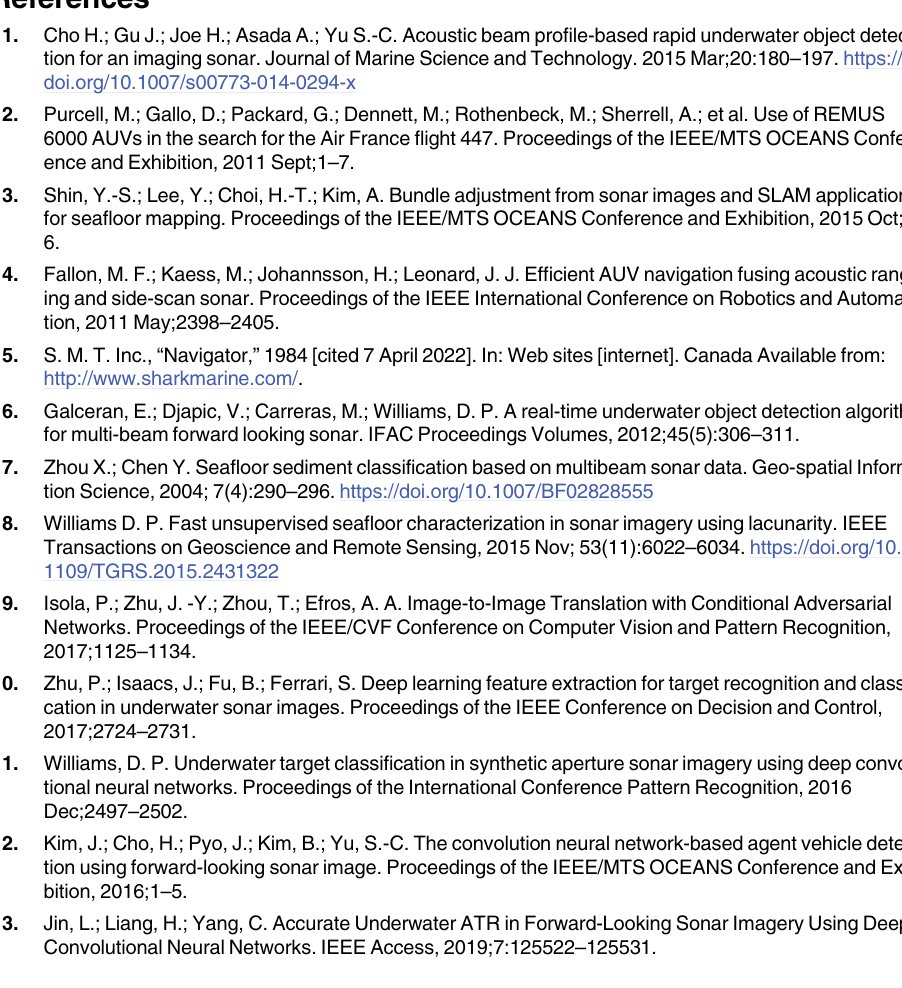
S3 Table. Abbreviation